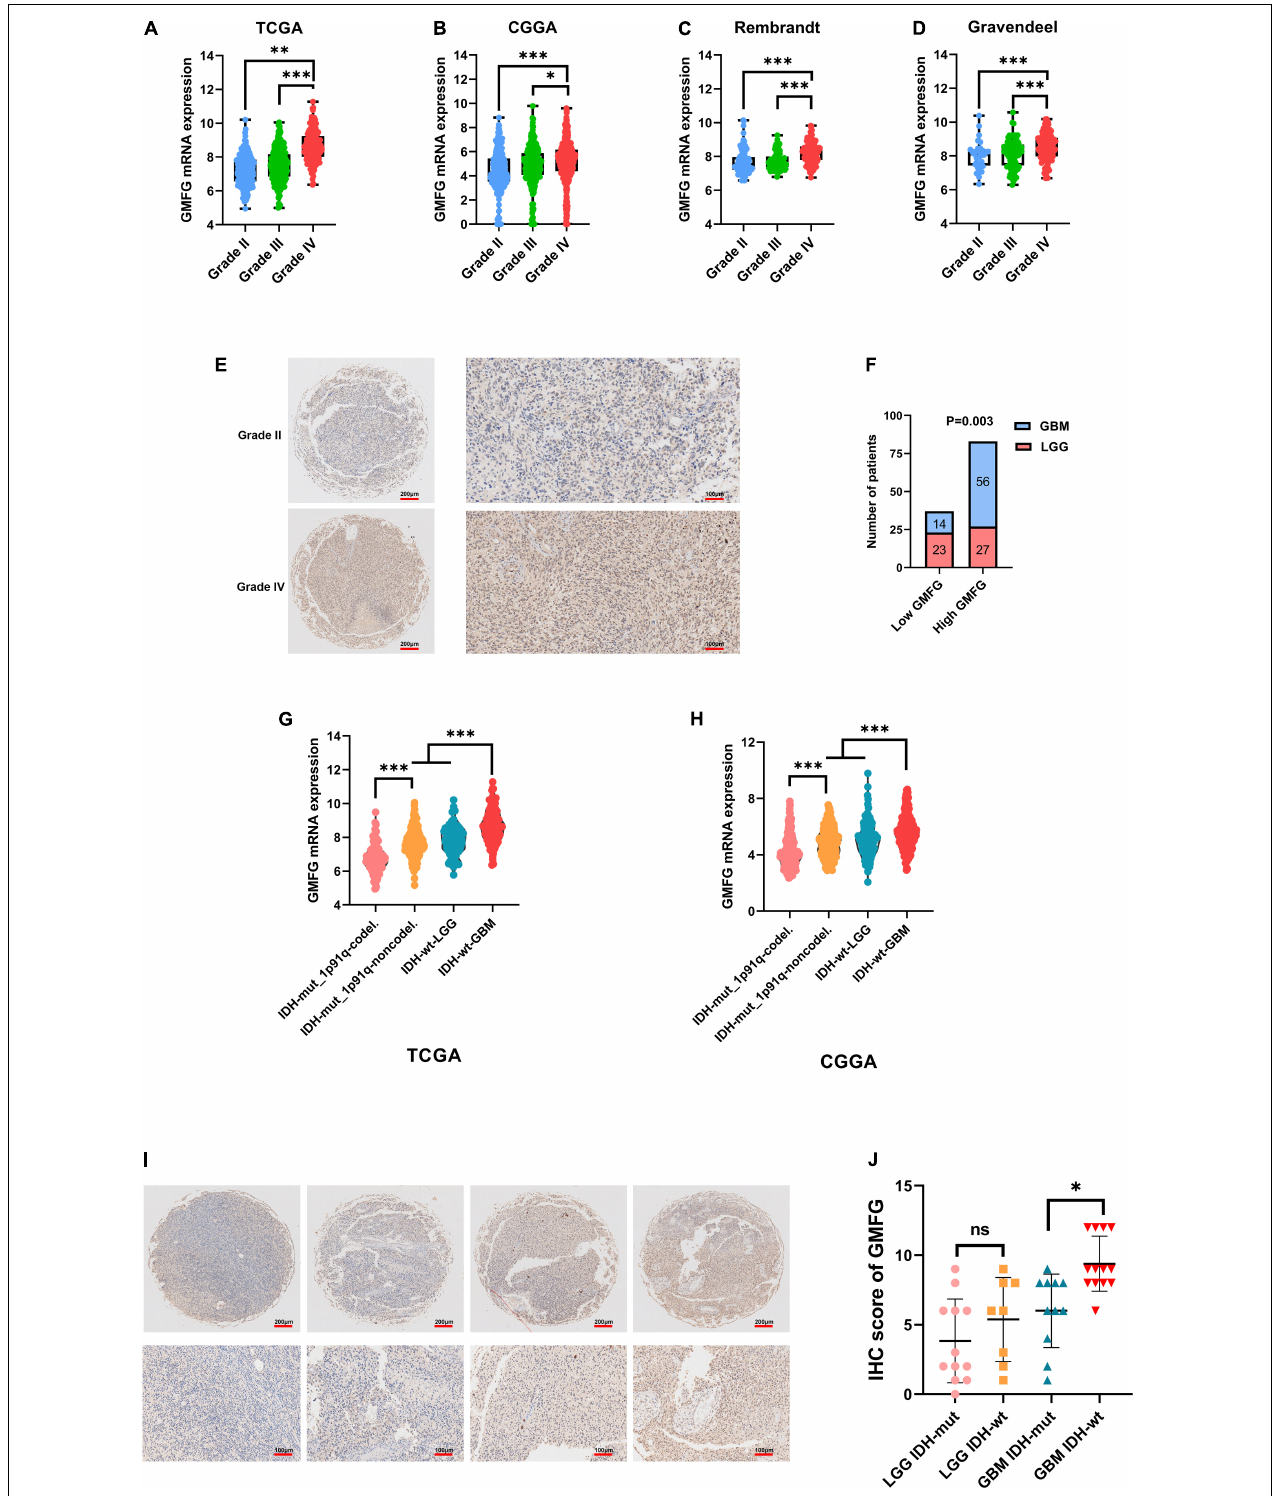
FIGURE 2 | Glia maturation factor- γ expression correlated with malignancy of gliomas. (A–D) TCGA, CGGA, Gravendeel, and Rembrandt were used to investigate GMFG expression in gliomas. All data were downloaded from GlioVis platform. (E,F) IHC staining of GMFG in lower grade gliomas (LGG) and glioblastoma (GBM); (G,H) GMFG expression in gliomas with different IDH and 1p19q status in CGGA and TCGA datasets; (I,J) gene sequencing of glioma tissues from our validation cohort. GMFG expression in gliomas with different IDH and 1p19q status. mut, mutant; wt, wild-type. ∗ P < 0.05, ∗∗ P < 0.01, ∗∗∗ P < 0.001, ns, no significance.